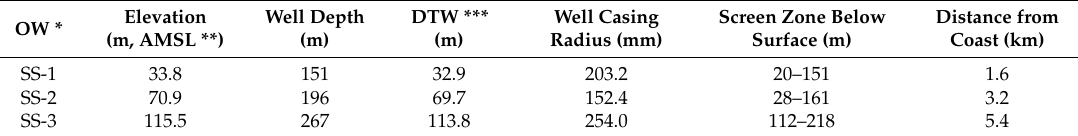
Table 1. Information about the monitoring